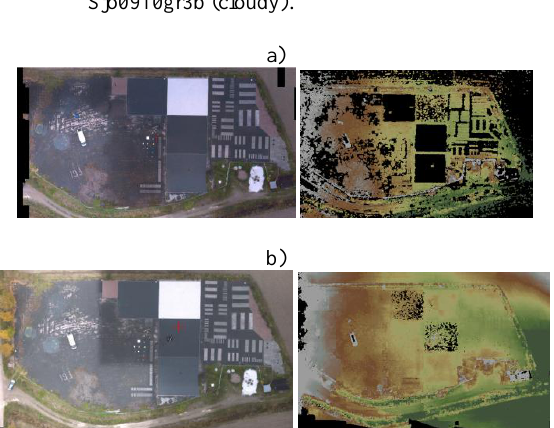
Figure 5. Orthophotomosaics and point clouds of the Sjökulla blocks a) Sjo0910gr3b and b)